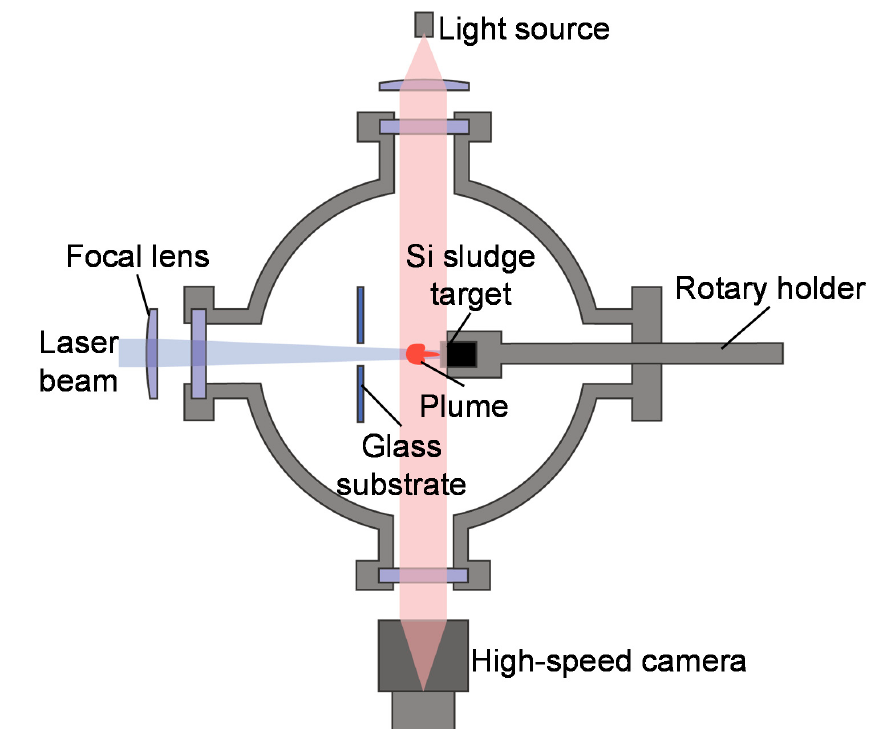
Figure 2. Schematic diagram of experimental setup.